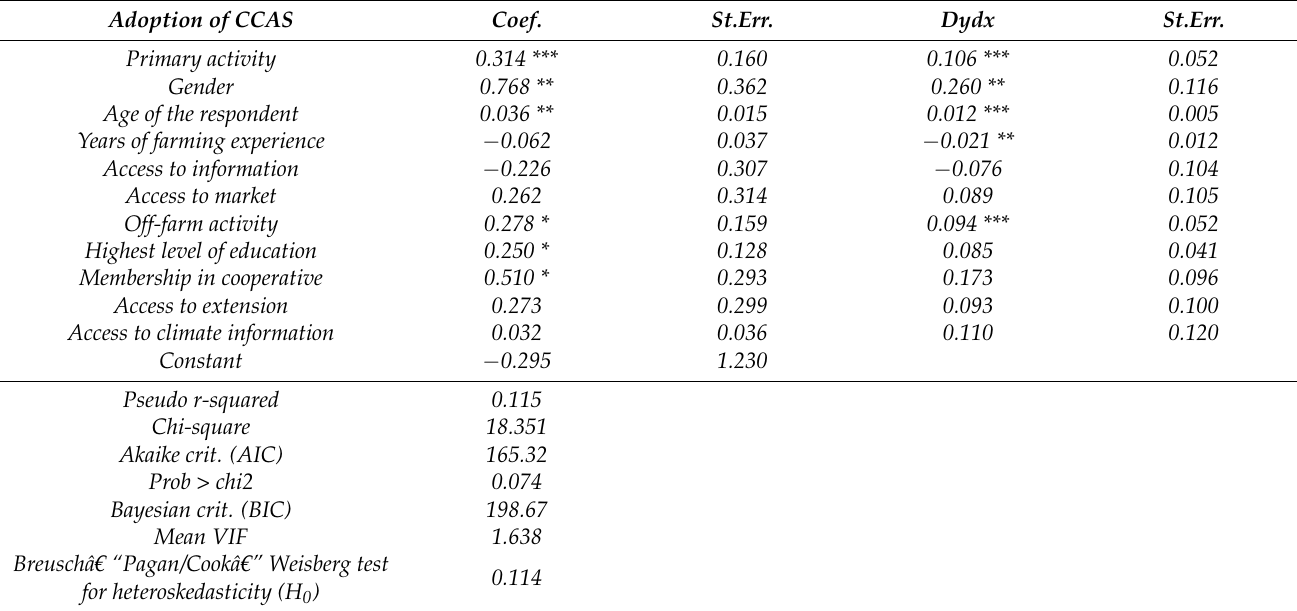
Table 3. Factors influencing the adoption of climate change adaptation strategies—Probit